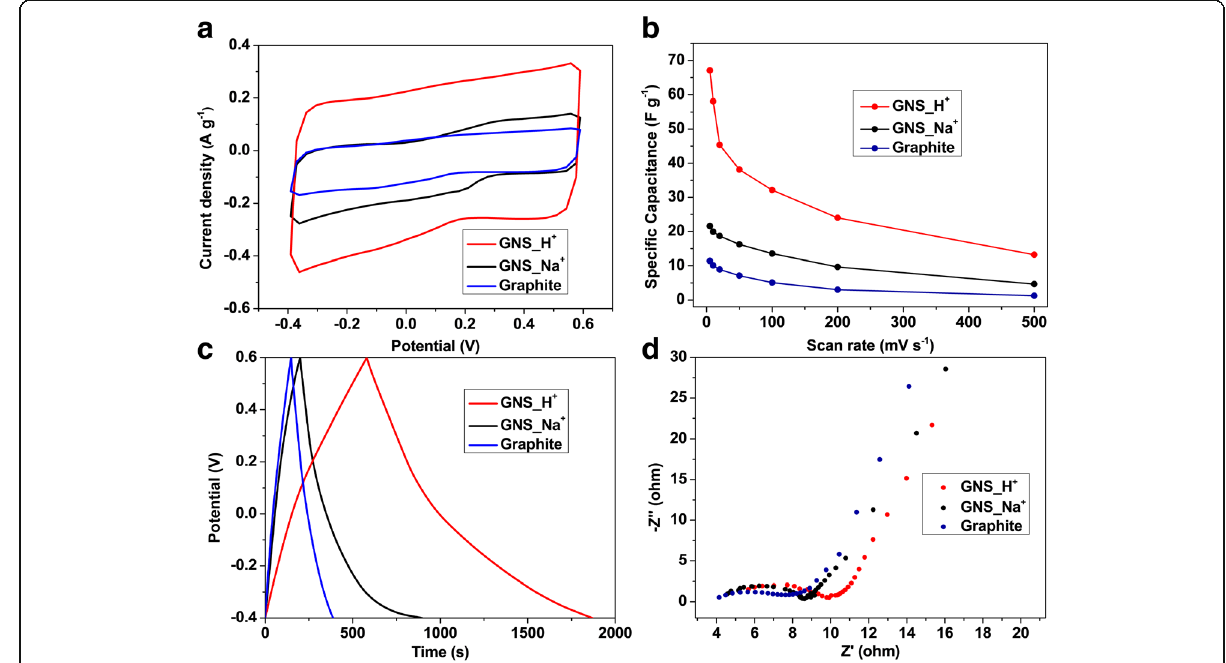
Fig. 6 a Cyclic voltammograms of the various samples, recorded at 5 mV s − 1 . b Specific capacitances of the samples, determined at scan rates from 5 to 500 mV s − 1 . c Galvanostatic charge/discharge curves recorded at 0.1 A g − 1 . d Nyquist plots of the samples measured from 100 mHz to 100 kHz; inset: corresponding expanded high-frequency region of the